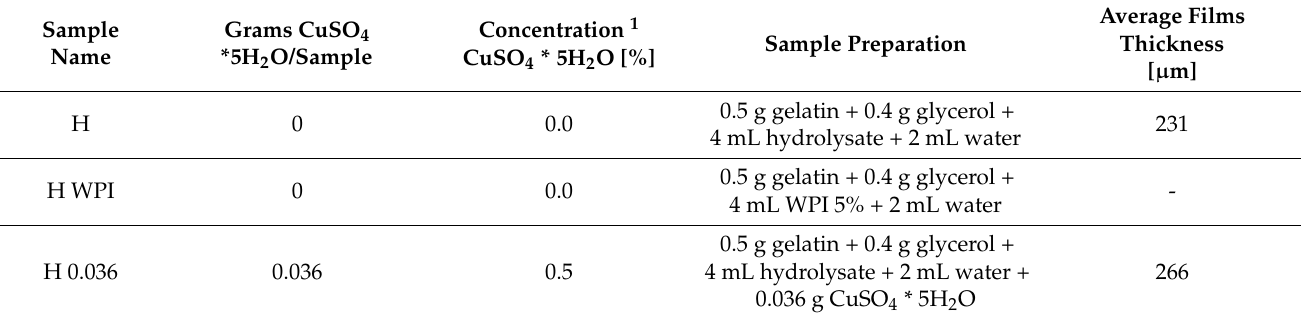
Table 1. The conditions for the obtaining of gelatin-whey